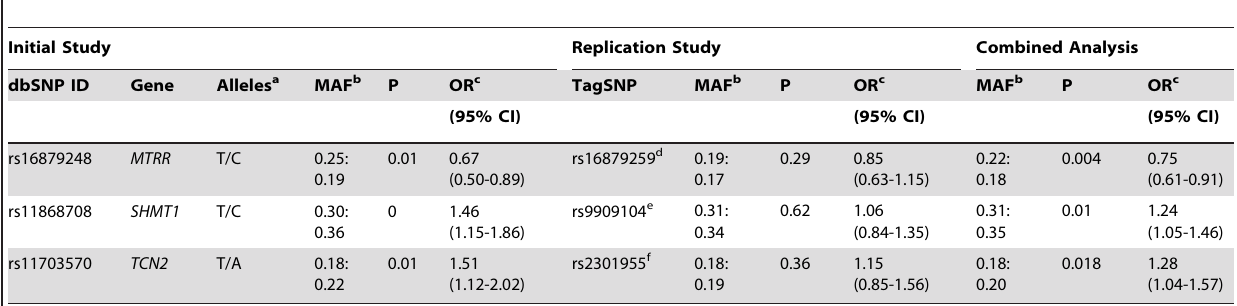
Table 2. Characteristics of Significant SNPs and Their Association with Ischemic Stroke Risk under Additive Model.